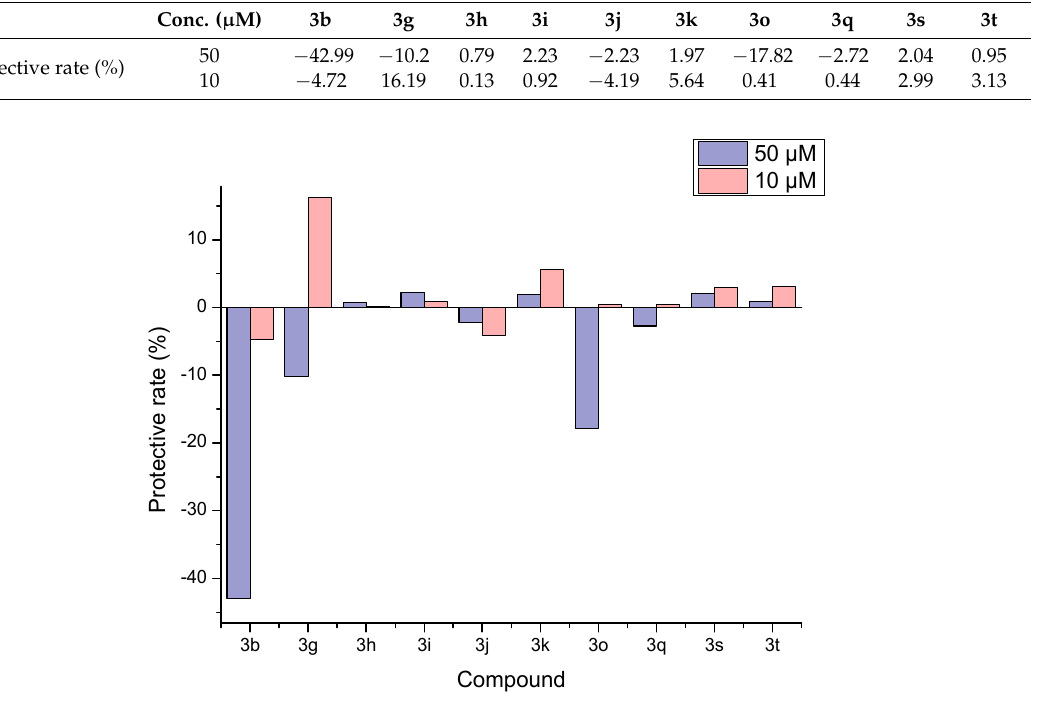
Figure 1. Protective rate (%) under MPP + treatment.